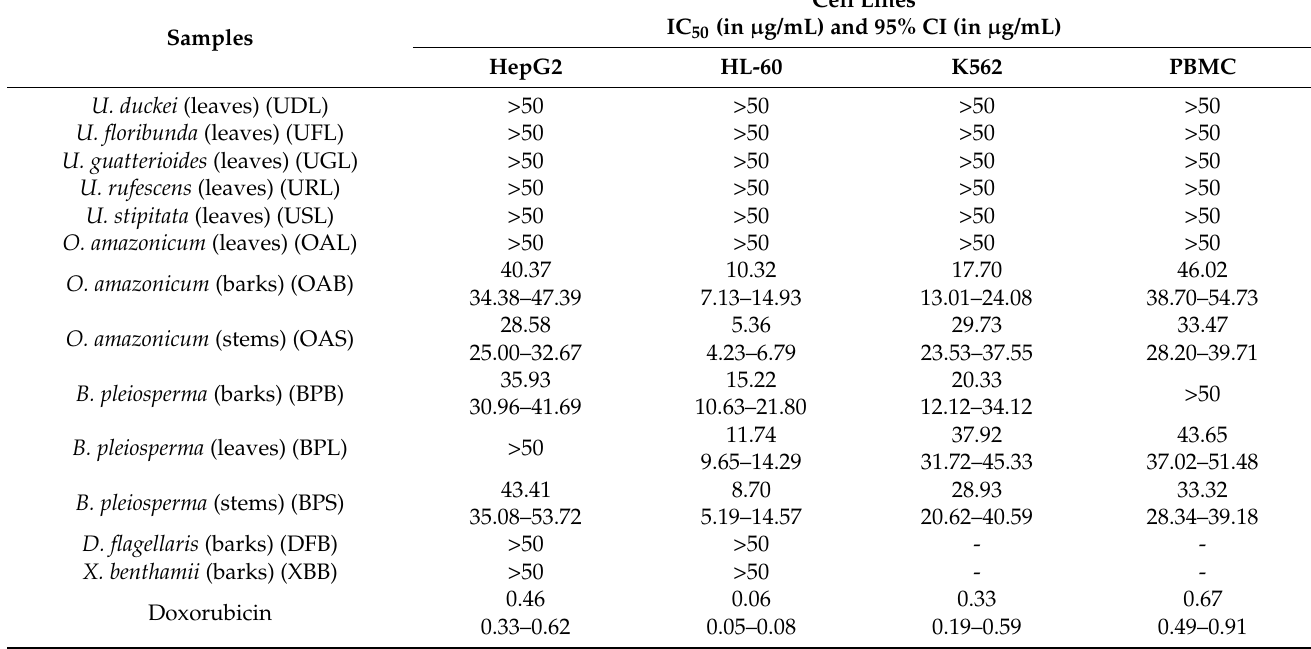
Table 2. Cytotoxic activity of essential oil